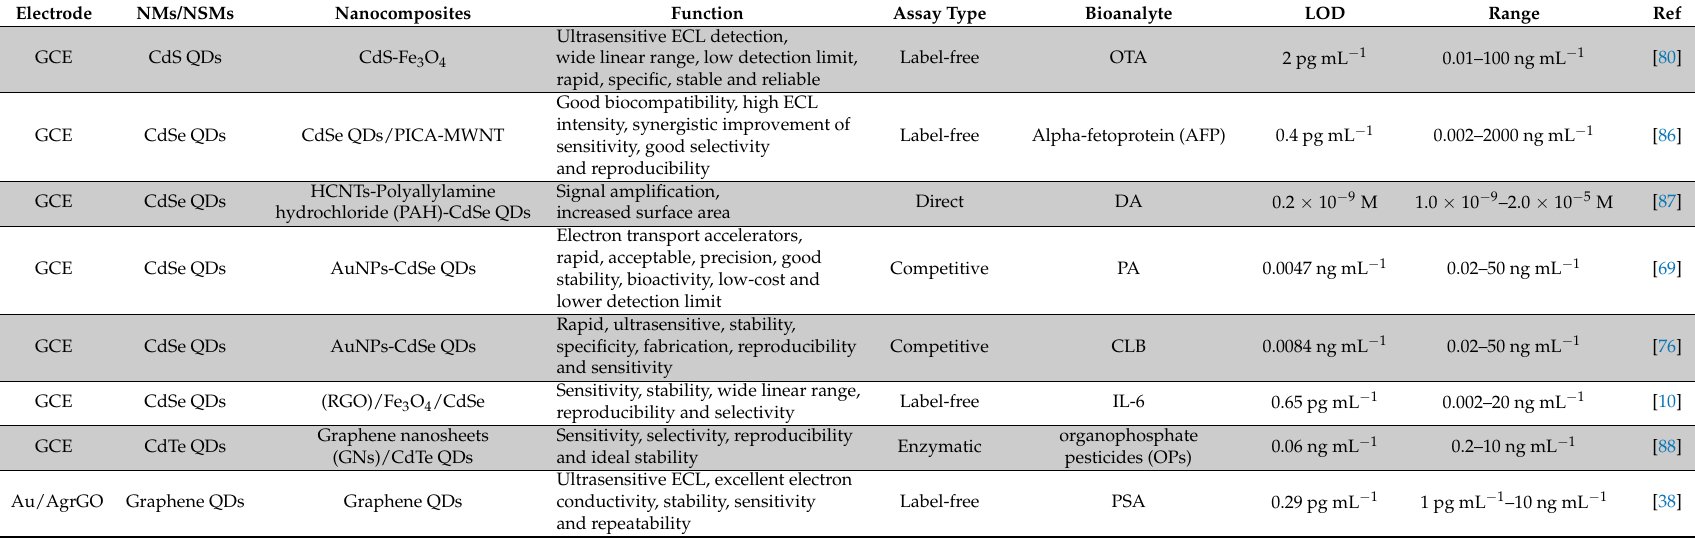
Table 3. Quantum dots-based ECL